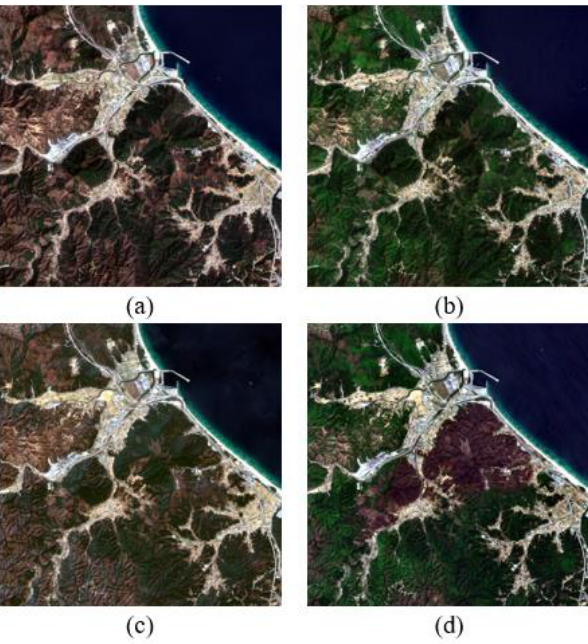
Figure 2. Sentinel-2 images used in this study; captured on (a) 20, 2019 (Copernicus Sentinel data 2019, processed by